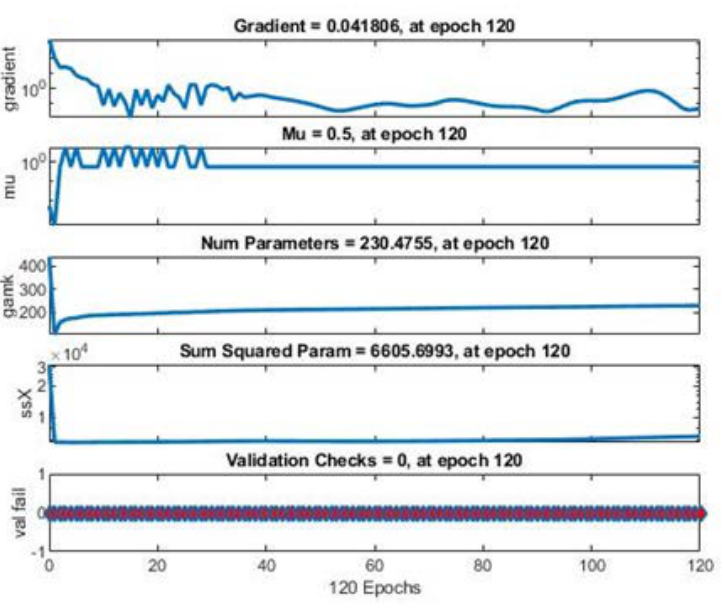
Figure 11. Training state.